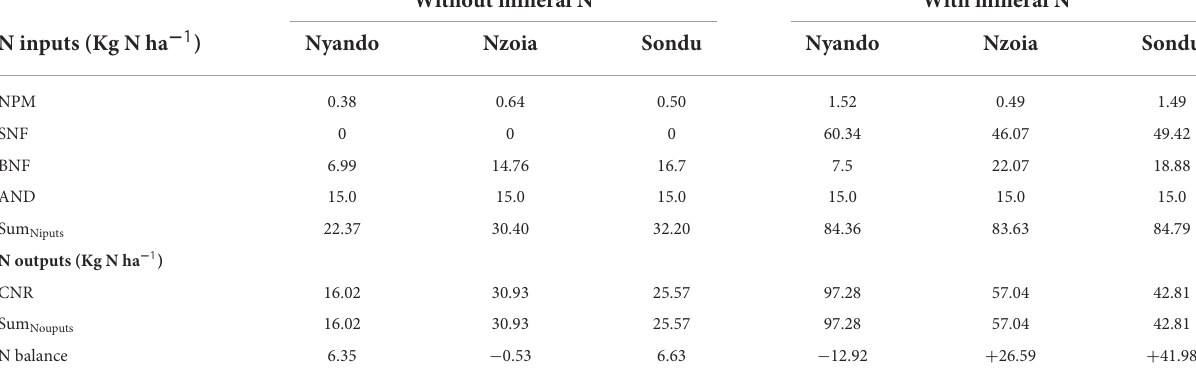
TABLE 3 Soil surface N budget for farms with and without mineral N